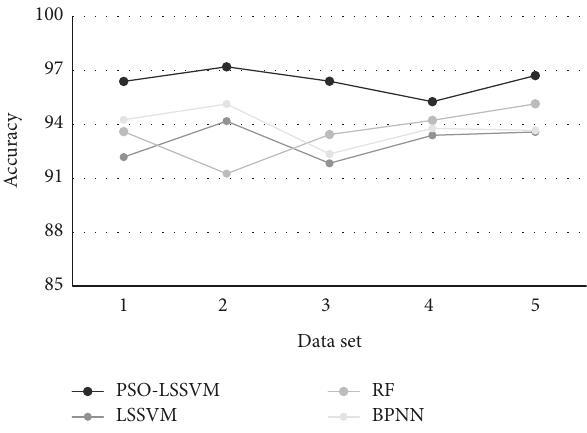
Figure 5: Comparison results of different methods on the training set. Table 2: Examples of ECCU evaluation based on the Particle Swarm Optimization-Least Squares Support Vector Machine (PSO-LSSVM)